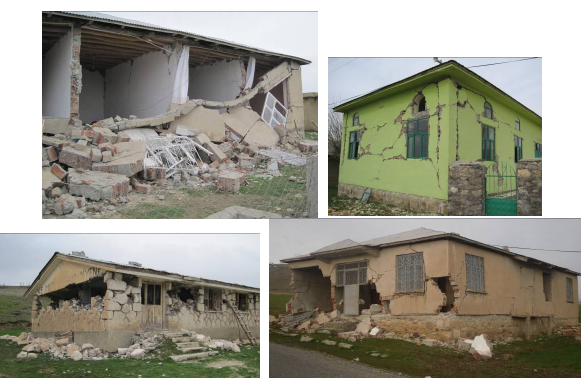
Fig. 1 Several failure of masonry houses observed after Elazig earthquake (2010) This paper discusses the effectiveness of masonry strengthening techniques The scope includes construction of Fig. 1. Several failure of masonry houses observed after Elazig one reference and eight strengthened identical 1/10 scaled one storey masonry houses and dynamic testing of earthquake (2010). specimens on uniaxial shaking table. The performance of each strengthening technique was compared with reference specimen.